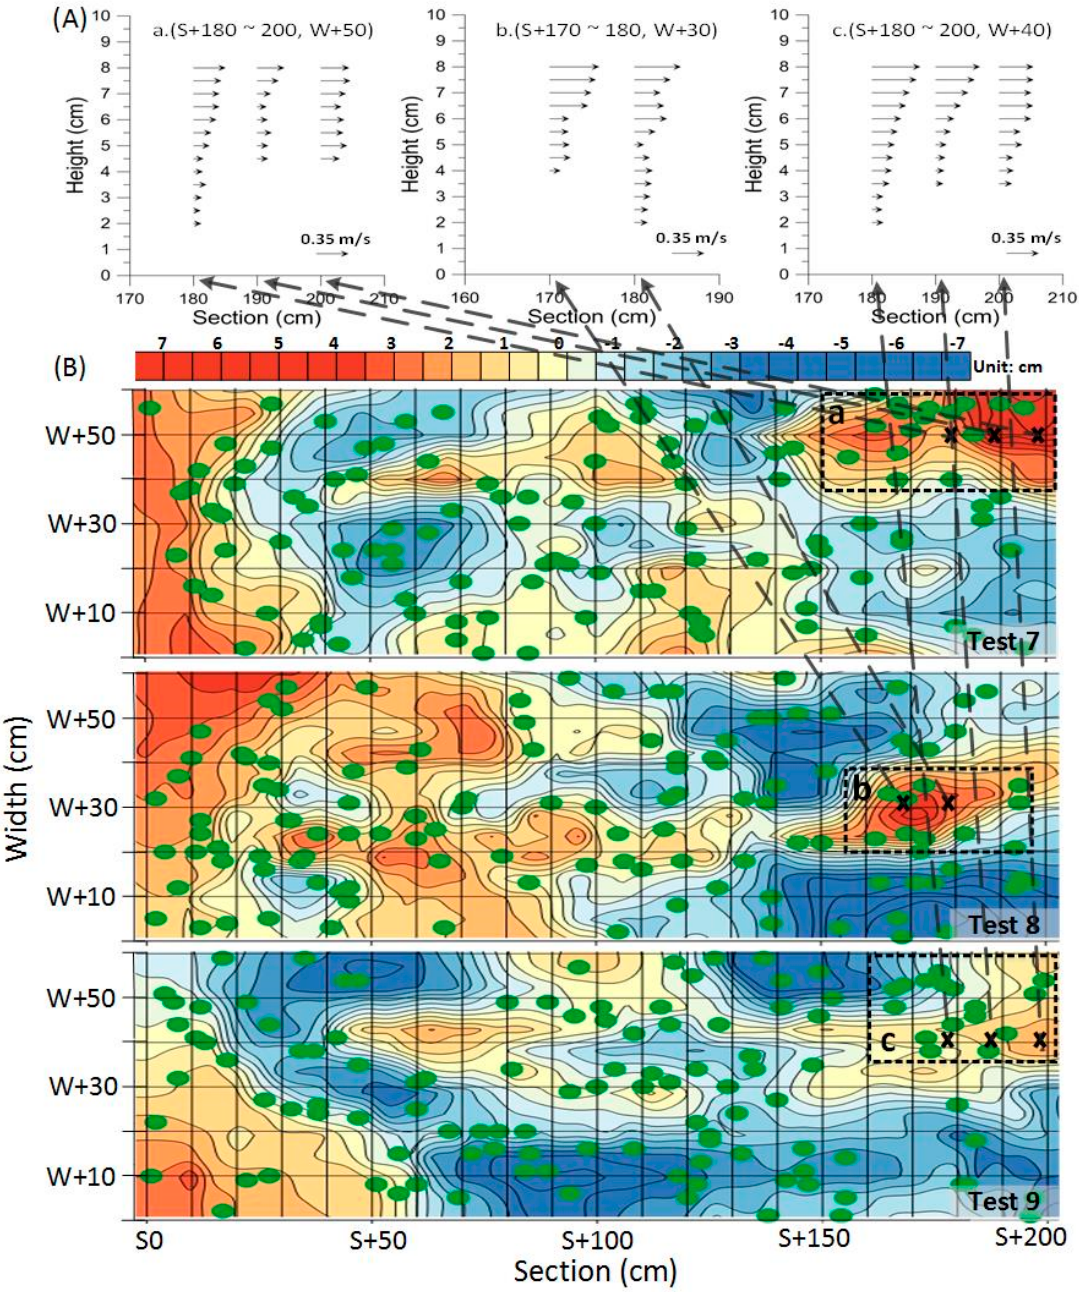
Figure 5. ( A ) The vertical velocity profile of low-velocity area at measuring points a (S+180 to 200, W+50), b (S+170 to 180, W+30), c (S+180 to 200, W+40). ( B ) The contour map of channel topography after the 100 stems/m 2 experiments (test 7–9). Green dots represent vegetation.